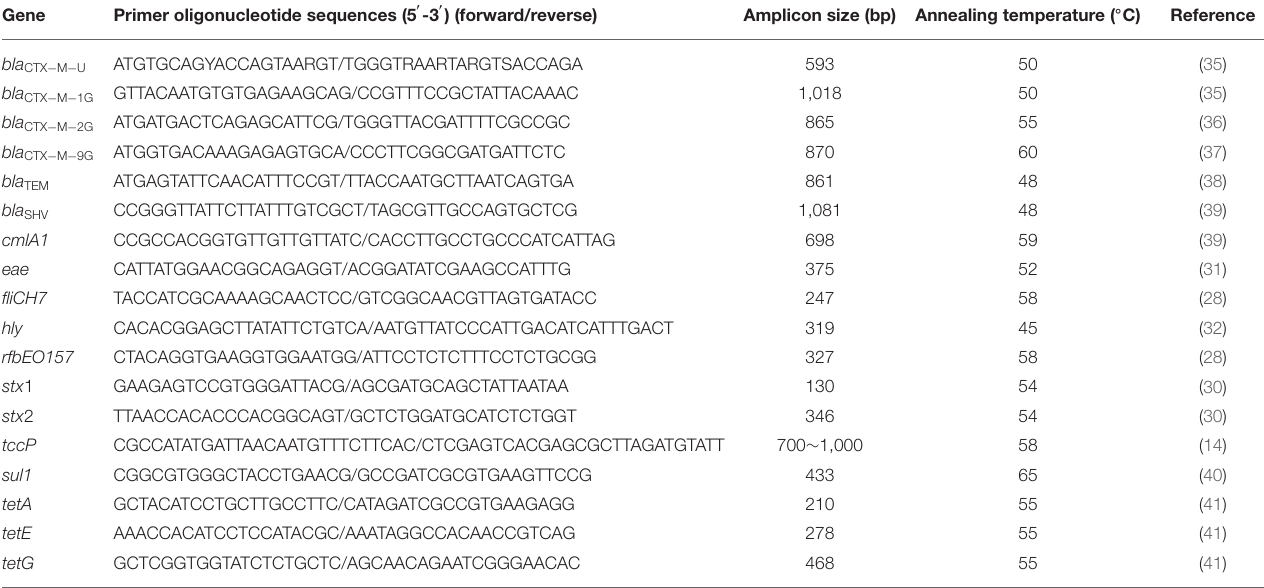
TABLE 1 | Primers used in PCR to detect targeted genes. Gene Primer oligonucleotide sequences (5 ′ -3 ′ )